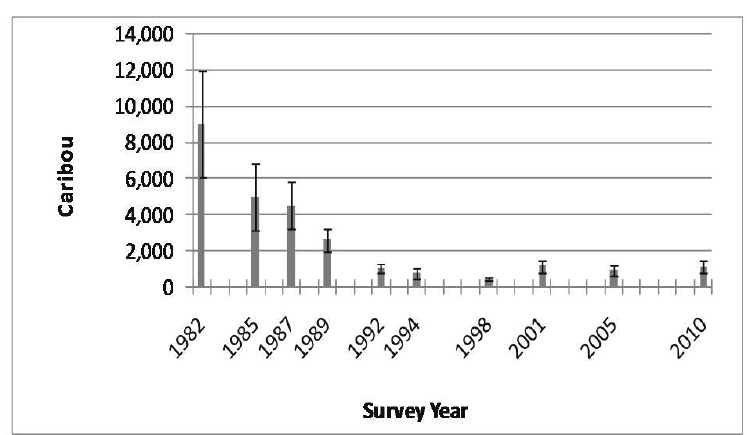
Fig. 2. Transects flown during the 2010 survey and distribution of adult caribou found ‘on’ and ‘off’ transect on northwest Banks Island,